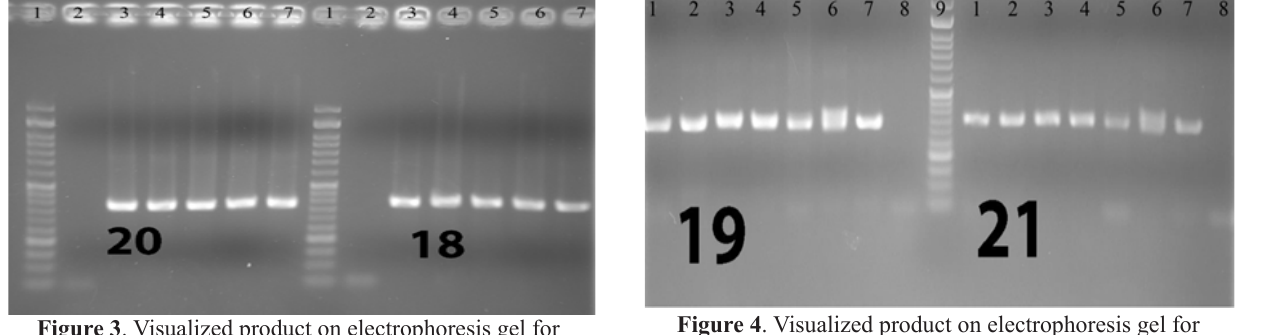
Figure 3 . Visualized product on electrophoresis gel for nested PCR of exons 18 and 20. 1: Ladder 2: Negative con- trol 3,4,5,6,7: Patients